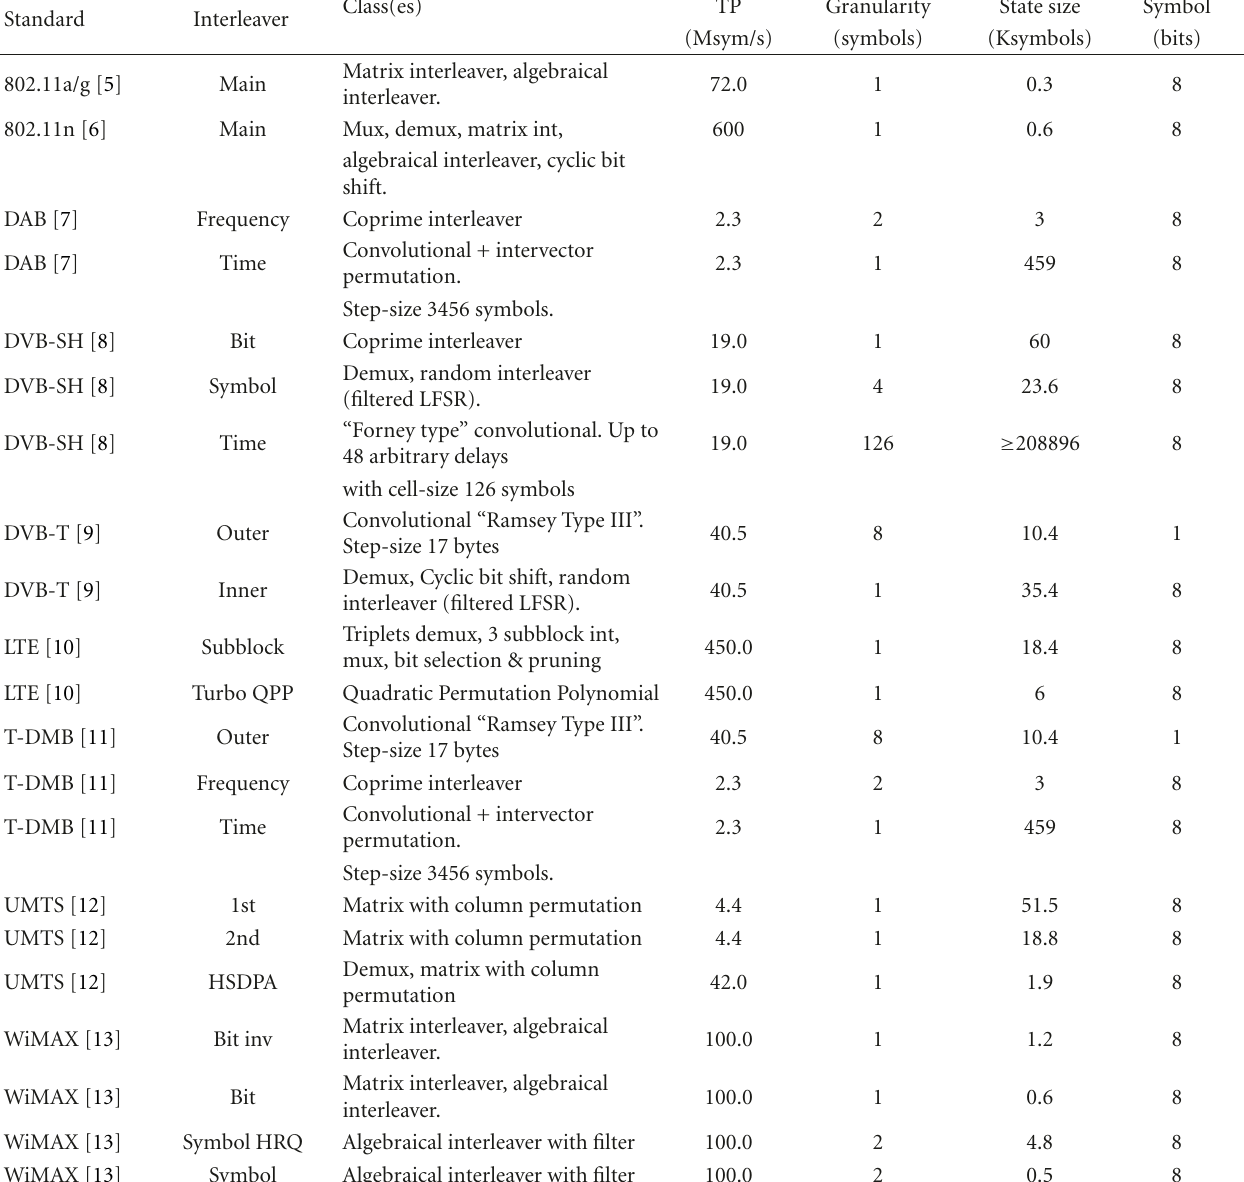
Table 1: Overview of interleaving functions and their characteristics for cellular, broadcast, and connectivity